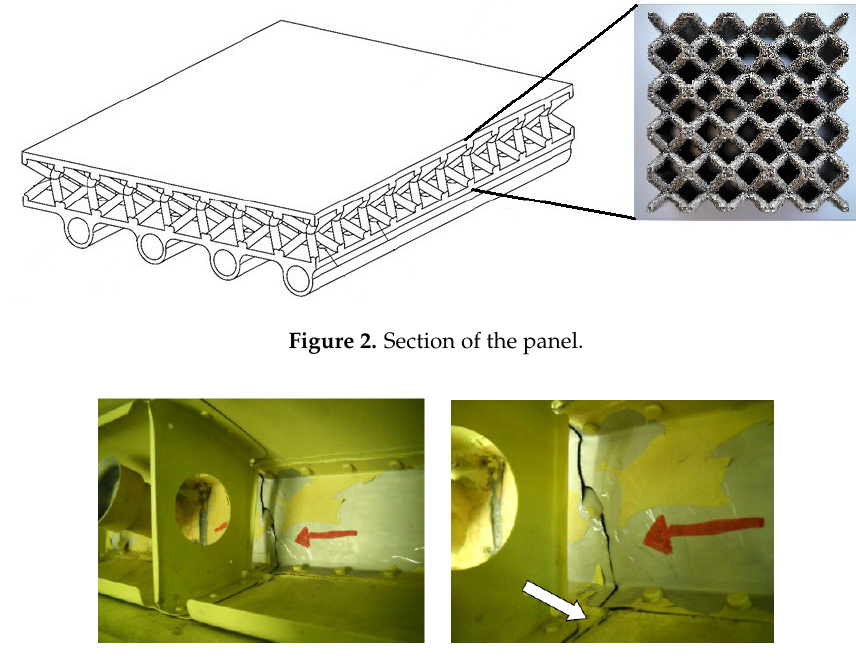
Figure 3. Internal structure of Piaggio thermal anti-icing system, with cracks evidenced by red arrows, courtesy of